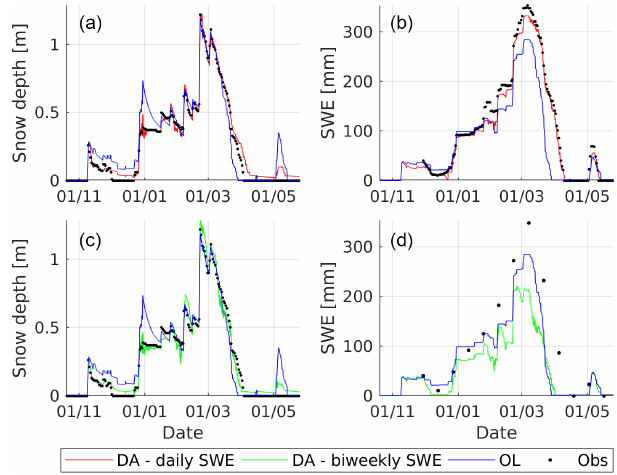
Figure 11. nP_Exp: effective sample size and ensemble spread as a function of the ensemble